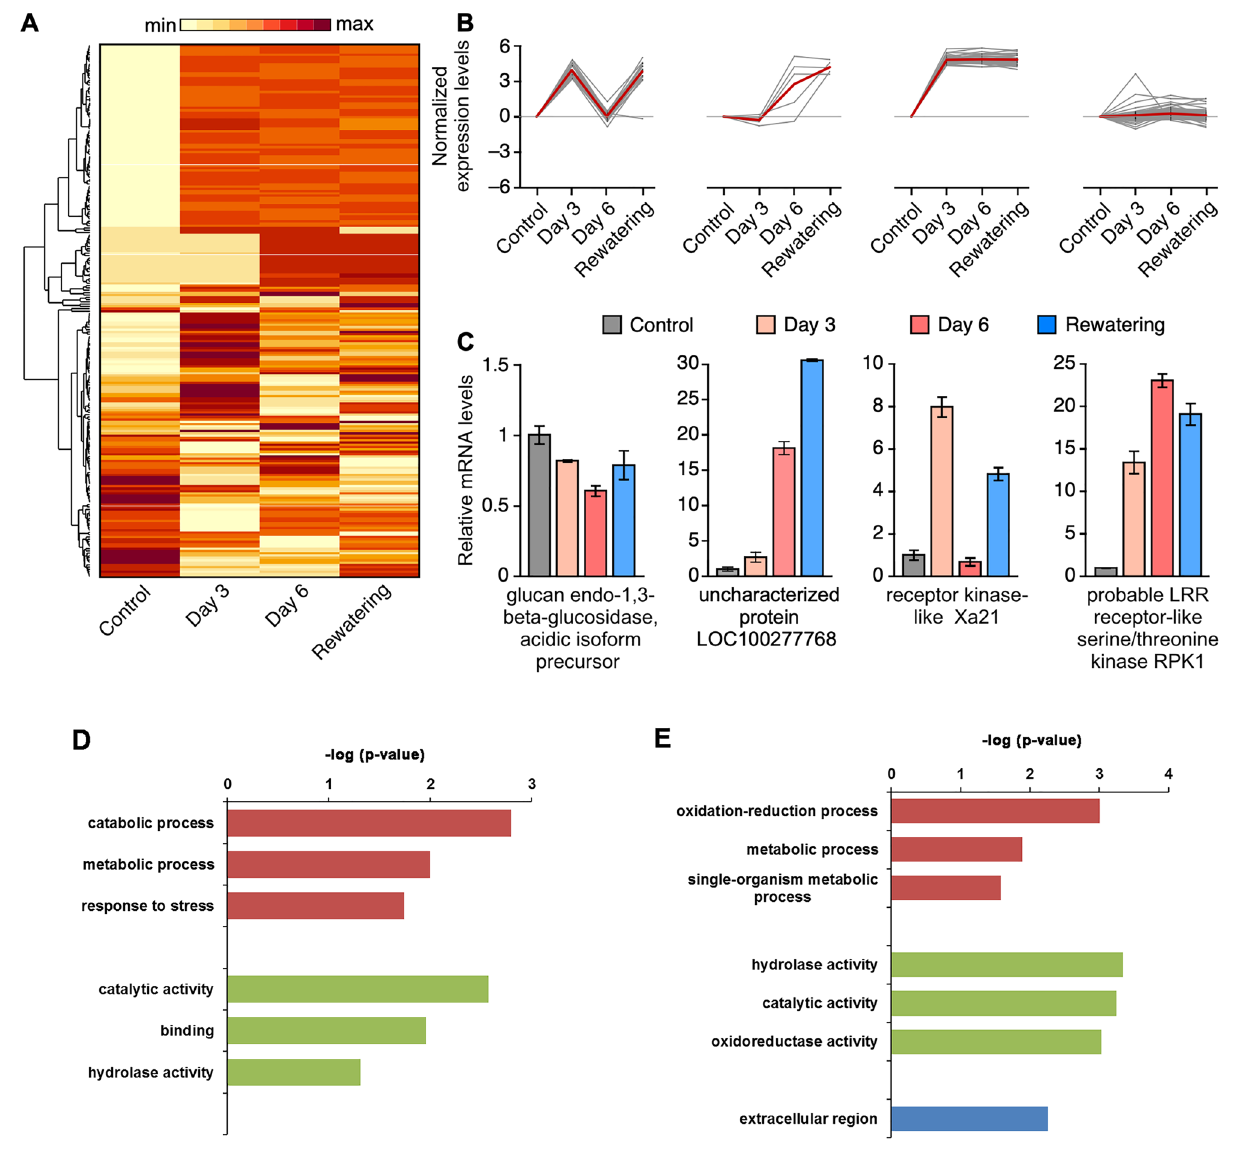
Figure 5. Cluster analysis of the DAPs during the drought treatments. ( A ) Heat map illustrating the expression profiles of the DAPs at three timepoints (3-d drought, 6-d drought, and rewatering). ( B ) Four enriched clusters of the gene expression profiles determined using the K-means algorithm. ( C ) Randomly selected DAPs were analyzed using RT-qPCR. ( D ) GO enrichment result of Cluster 3 proteins. The red color represent BP (biological process), the green color represent MF (molecular function) and the blue color represent CC (cellular component). ( E ) GO enrichment result of Cluster 4 proteins. The red color represent BP (biological process), the green color represent MF (molecular function) and the blue color represent CC (cellular